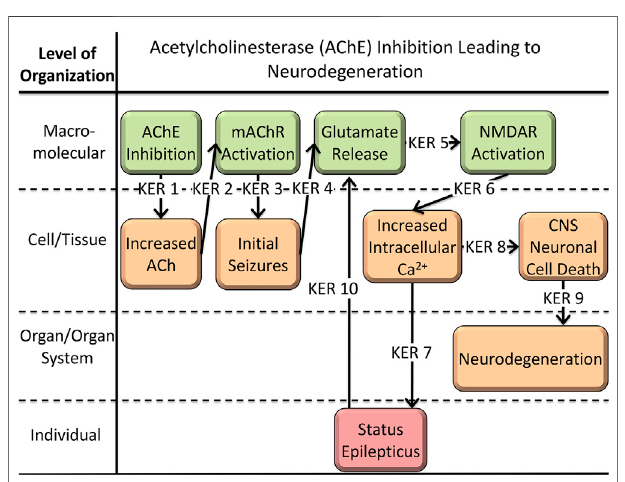
FIGURE 1 | Graphical representation of AOP 281: AChE Inhibition Leading to Neurodegeneration (Conrow et al., 2021). Each arrow represents the key event relationship (KER) between key events (KE) of the AOP.